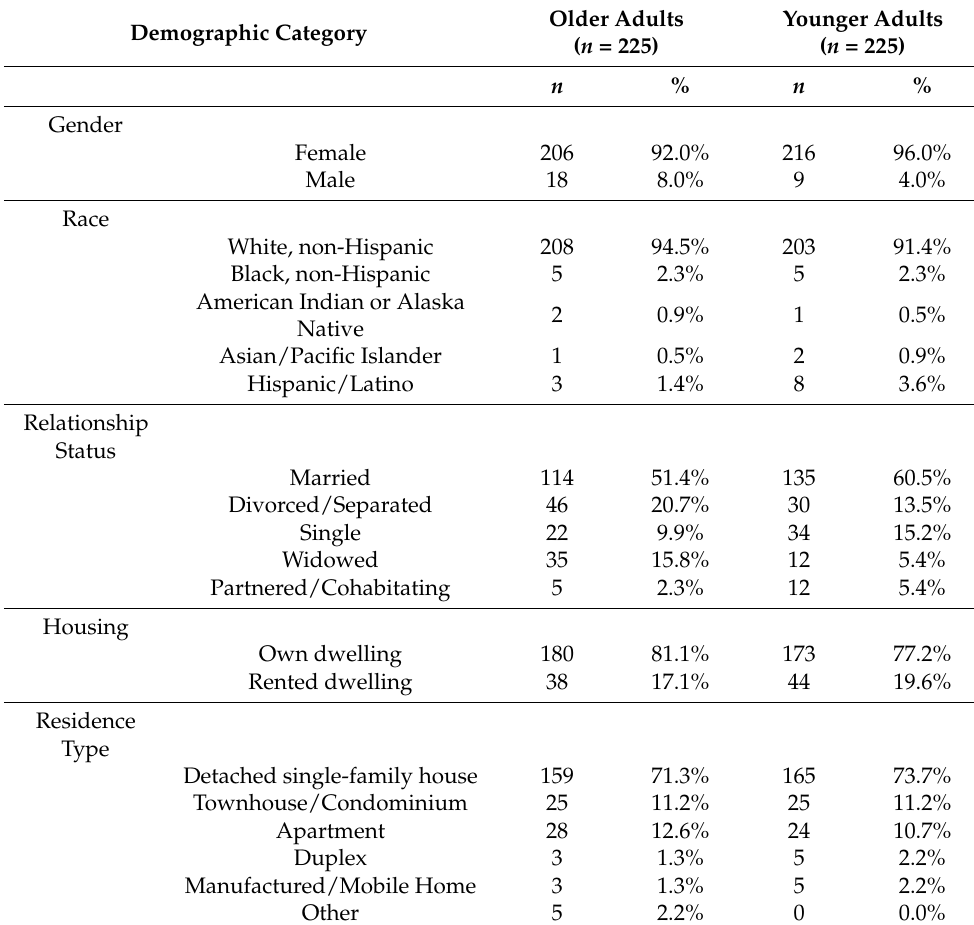
Table 1. Demographic Breakdown for